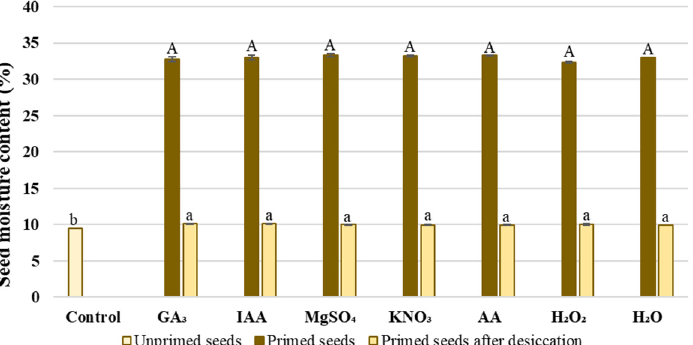
Figure 1. The moisture content in unprimed wheat seeds, in primed seeds immediately after priming and in primed seeds after desiccation before germination; the values represent the means of five replicates ± standard error. Different small letters above bars indicates significant differences between unprimed seeds and primed seeds after desiccation. Same capital letters indicate significant differences after application of different priming agents using Tukey test ( p ≤ 0.05).